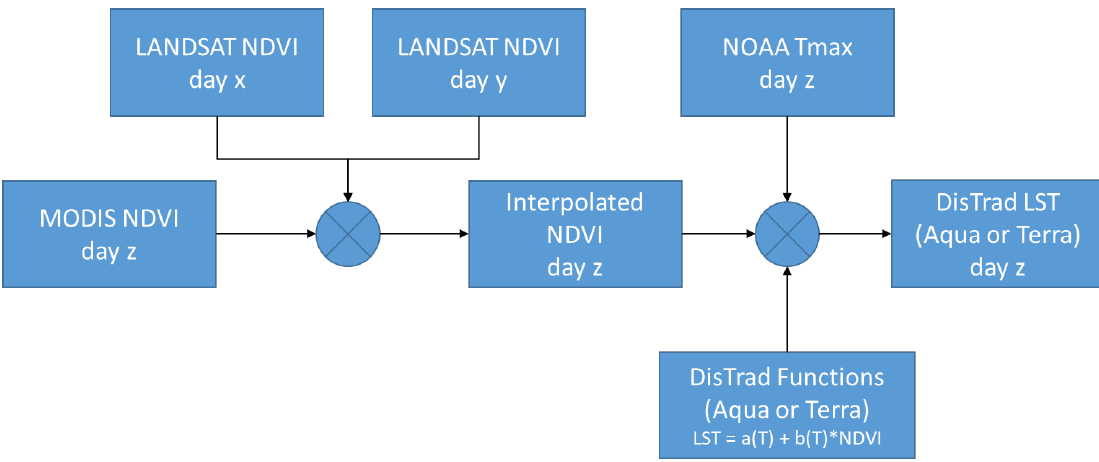
Figure 2. Flowchart—step 2—Day-specific high-resolution simple DisTrad LST.